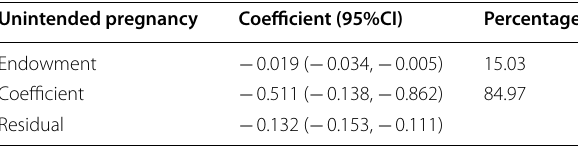
Table 3 The overall decomposition analysis of the decrease in unintended pregnancy among reproductive-age women in Ethiopia, 2000 to